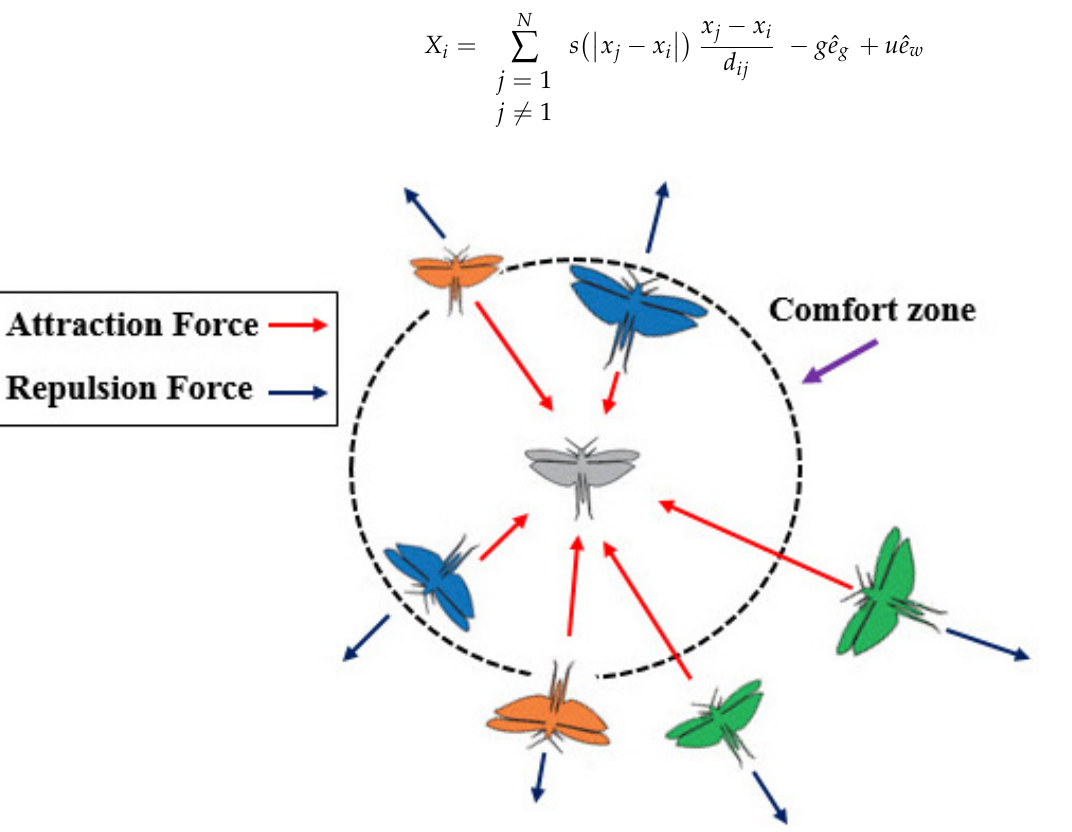
Figure 2. Attraction force, repulsion force, and comfort zone in primary corrective patterns among individuals in a swarm of grasshoppers.